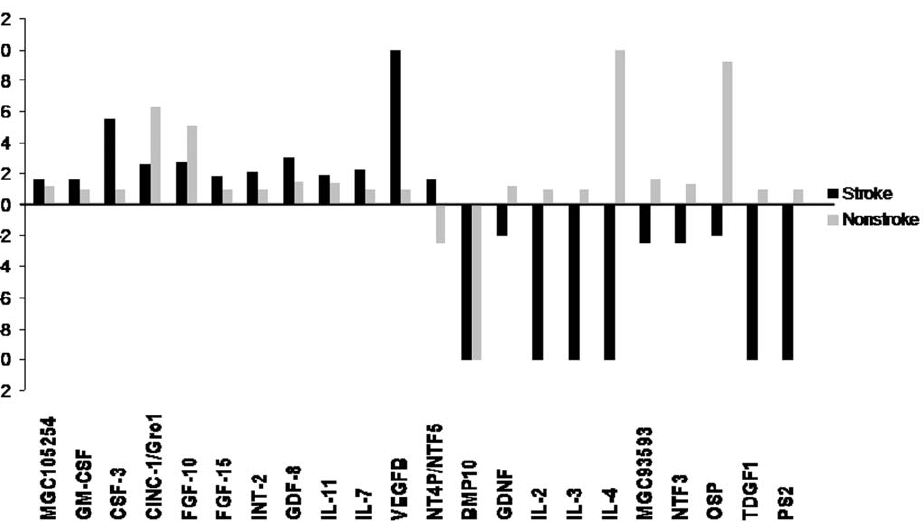
Figure 1. PCR array. PCR array was performed on the brain tissue homogenates from candesartan and saline treated animals (n=2). Brain tissue samples were taken from both hemispheres as shown in Figure 4a. Regulated genes are presented as fold changes. Positive values mean upregulated and negative values mean downregulated.12 genes were upregulated and 10 genes were downregulated more than 1.5 fold in candesartan-treated animals, compared to saline-treated animals. VEGFB was particularly upregulated by candesartan.